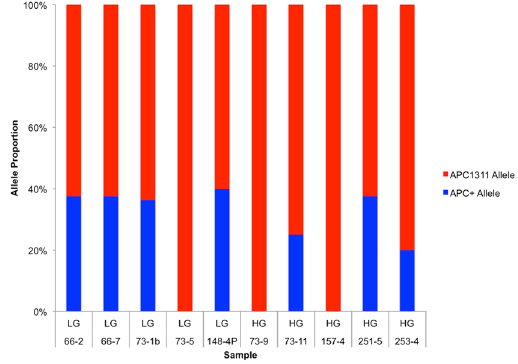
Figure 3. Proportion of APC 1311 and APC + allele expression in LG-IEN and HG-IEN whole samples. Mutant and wild type APC alleles can be distinguished by the replacement of G by T in codon 1311 (GAA), which introduces a premature stop codon. The allele proportion was based on raw RNA sequencing reads mapped in this region.